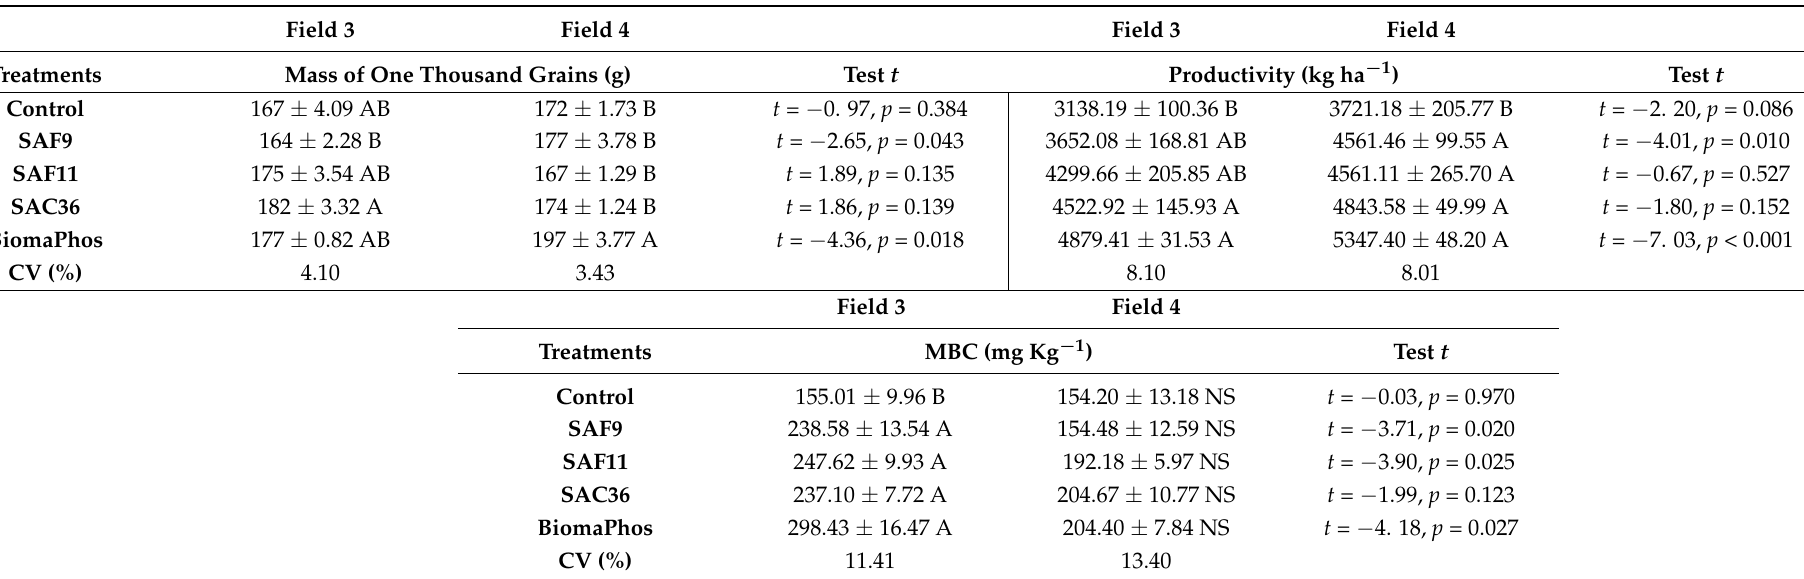
Table 7. Effect of inoculation with plant-growth-promoting rhizobacteria on thousand-grain mass, yield, and microbial biomass carbon (MBC) sampled in the soil of Glycine max L. plants grown in summer 2020/2021, in two experimental fields of soybean cultivation in the interior of the state of Goi á s, Brazil, with different histories of soybean cultivation: Field 3, soybean production for 10 years and Field 4, second year of soybean